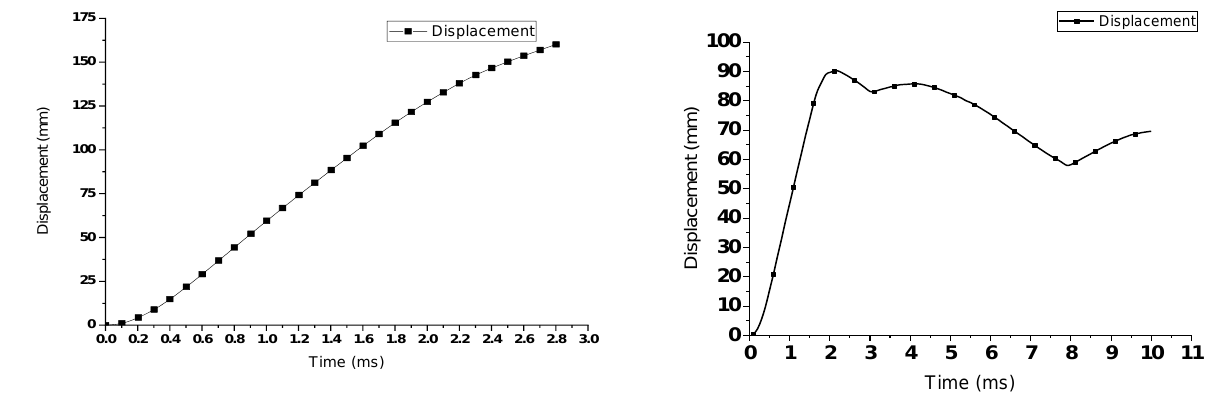
( b ) Displacement time history with the mitigation system Figure 22. The displacement response. Figure 22. The displacement